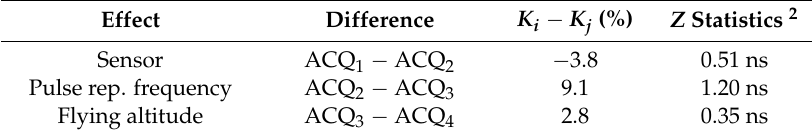
Table 8. Test of differences between overall Kappas ( K ) derived from classification of trees and non-tree objects in cross validation of logistic regression models based on multinomial 1 response for different combinations of acquisitions. Effect Difference K i ´ K j (%) Z Statistics 2 ACQ 1 ´ ACQ 2 ´ 3.8 ACQ 3 ´ ACQ 4